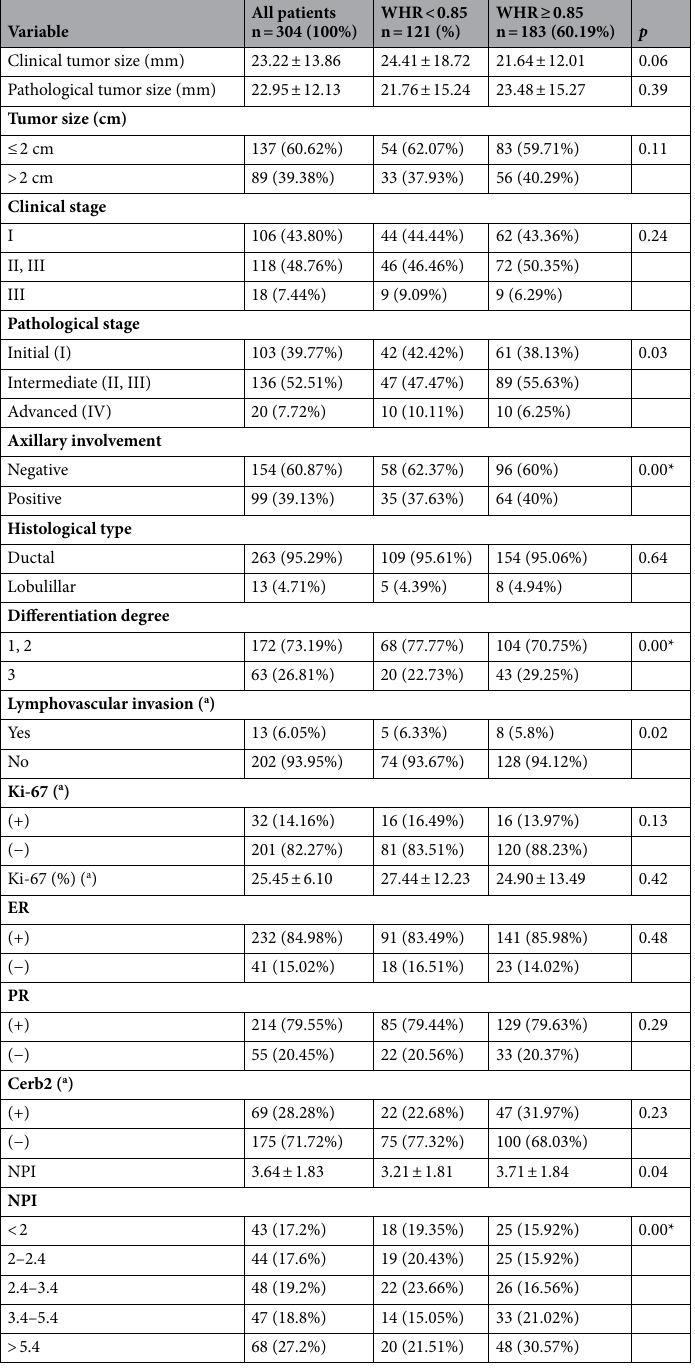
Table 6. Prognostic tumor characteristics in patients with breast cancer according to WHR (central obesity vs. no central obesity). Data expressed as means ± standard deviation and absolute numbers and their frequencies. NPI Nottingham prognostic index. * p value < 0.05 (t-Student or Chi-squared). a Analysis performed on the cases provided by the pathology